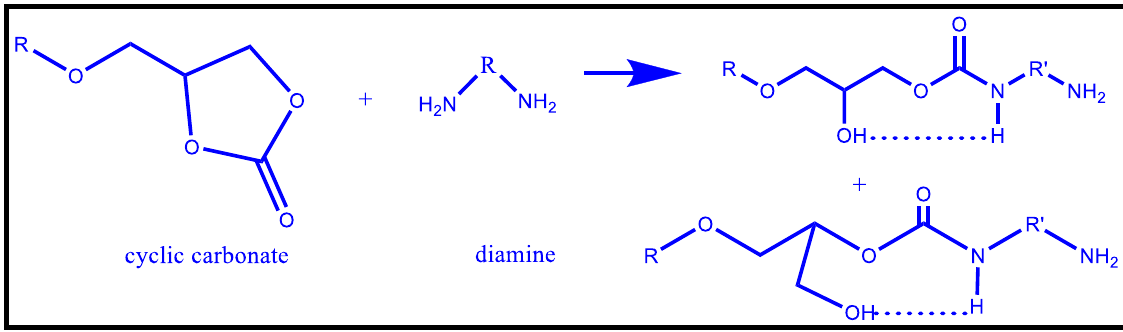
Figure 10. Reaction of Cyclic Carbonates and Amines [110].